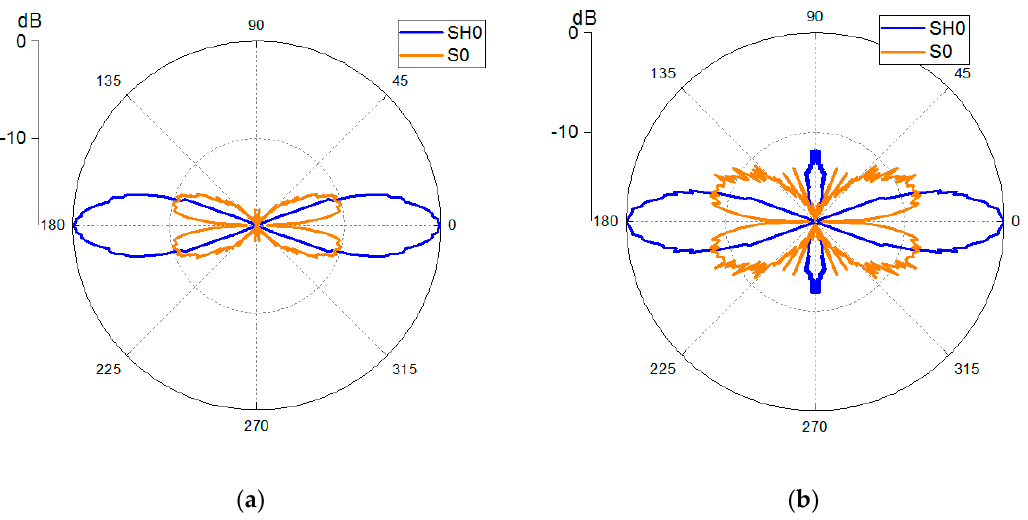
Figure 18. A comparison of measured wave field snapshots between ( a ) the dual SHPFP and ( b ) the original SHPFP at 50.24 µs after excitation. The wave packets in the solid green circles are the SH0 waves, and the ones in the dotted red circles are the unwanted S0 Lamb wave. For the complete videos of the wave propagation, see the section Supplementary Materials at the end of the paper.